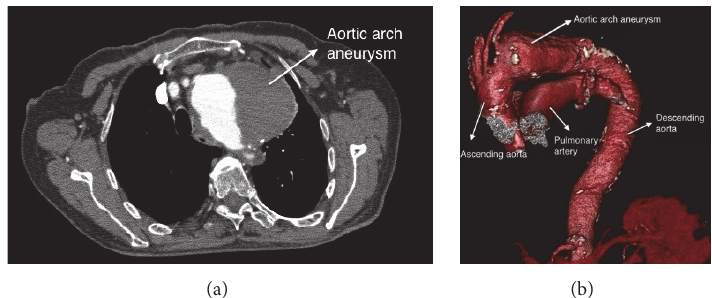
Figure 1: (a) Computed tomography (CT) angiography view of 10cm diameter aneurysm which includes zone 2 area. (b) Computed tomography (CT) angiography view of 10cm diameter aneurysm which includes zone 2 area.